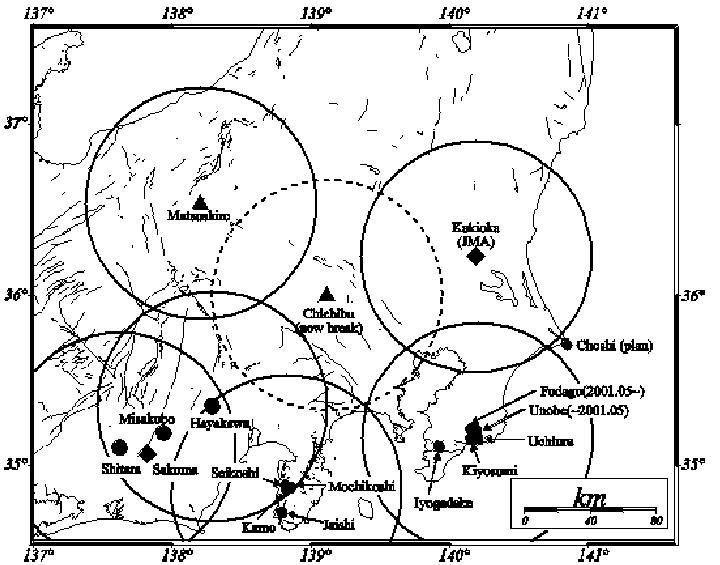
Figure 3. A ULF network in the Kanto (Tokyo) area. A triangle indicates the installation of an induction magnetometer and a circle, the torsion-type magnetometer. Kakioka observatory is equipped with induction magnetometers. A box indicates the fluxgate magnetometer.